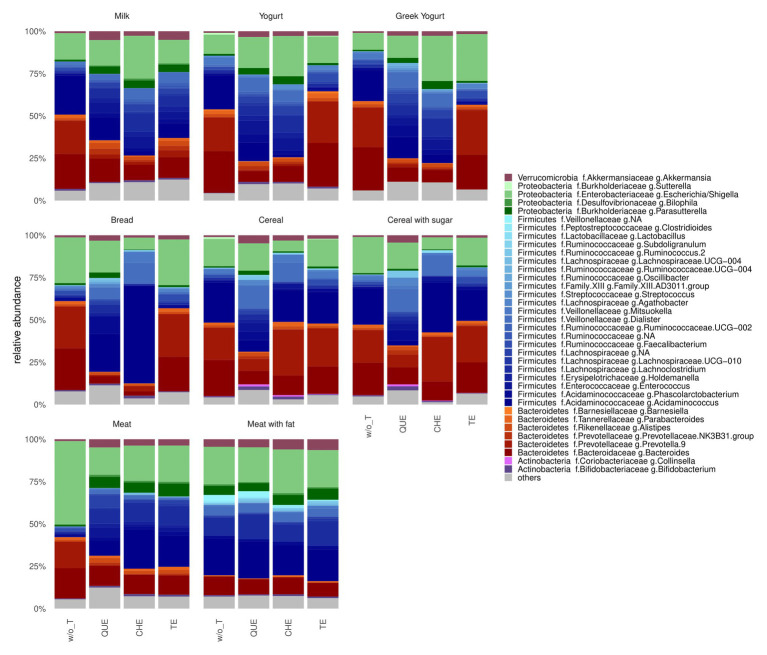
Barplot of gut microbial community structure at genus level. w/o T, without tannins; QUE, quebracho tannins extract; CHE, chestnut tannins extract; TE, tara tannins extract. Relative abundance obtained by total-sum scaling (TSS) from genus-level abundance table. “Others” include genera with relative abundance lower than 1% for all conditions.